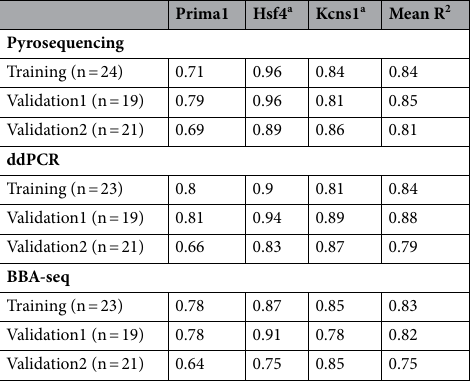
Table 1. Correlation of DNAm and chronological age in different targeted approaches. a CpGs from the amplicons were always selected by the highest Pearson correlation with chronological age, therefore they are not identical in the different sequencing